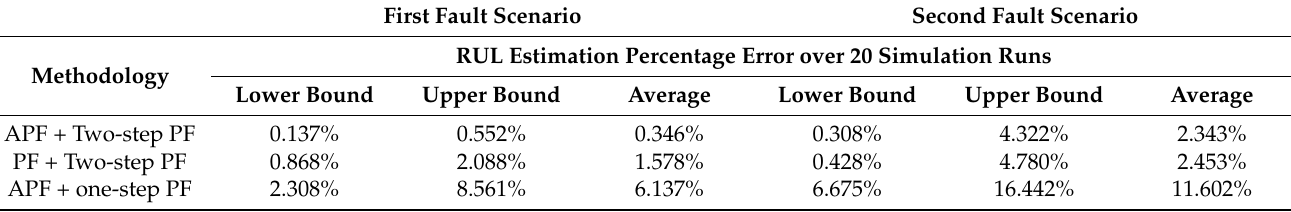
Table 7. RUL estimation